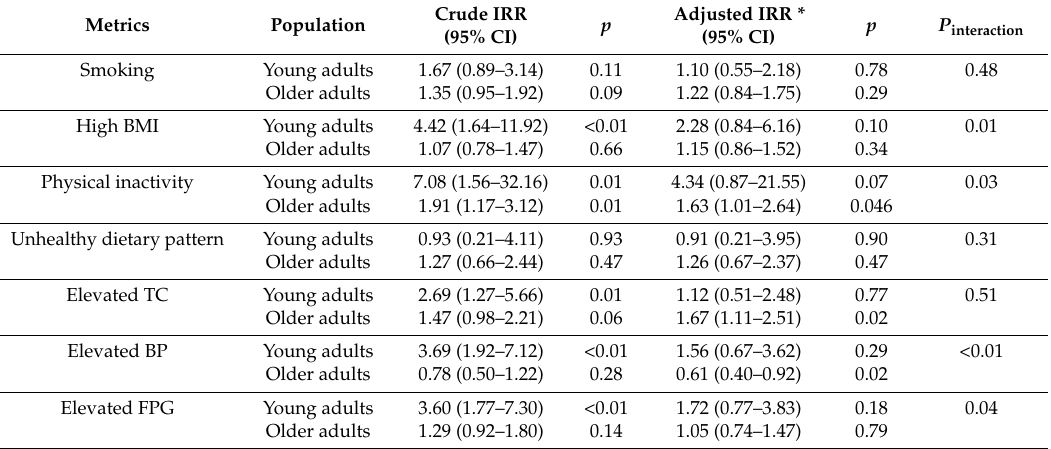
Table 3. IRRs between individual CVH metrics and IHD prevalence, stratified by